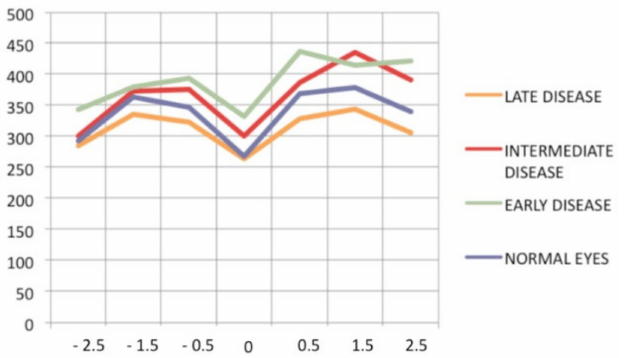
Figure 45. Progression of retinal disease as followed by optical coherence tomography (x axis indicates distance from fovea (=0); y axis indicates thickness of retina in microns). Early disease (green line) features thickening of the retina (and to a lesser degree, the fovea). In late disease (yellow line), there is diffuse thinning, except in the fovea; foveal thickness remains comparable to normal (purple line) (from Ophthalmic Surg Lasers Imaging 2012; 43-suppl S25–31). Optical coherence tomography also provided information about the vitreo-retinal interface; it revealed the presence of thin, pauci-contractile epiretinal membranes in up to 93% of cases